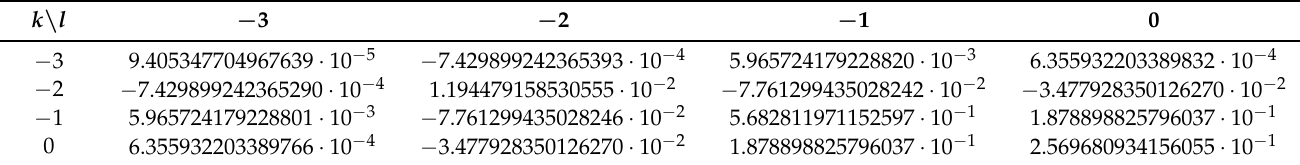
; [ 0,1 ]) evaluated up to machine precision. ( 3,1 )